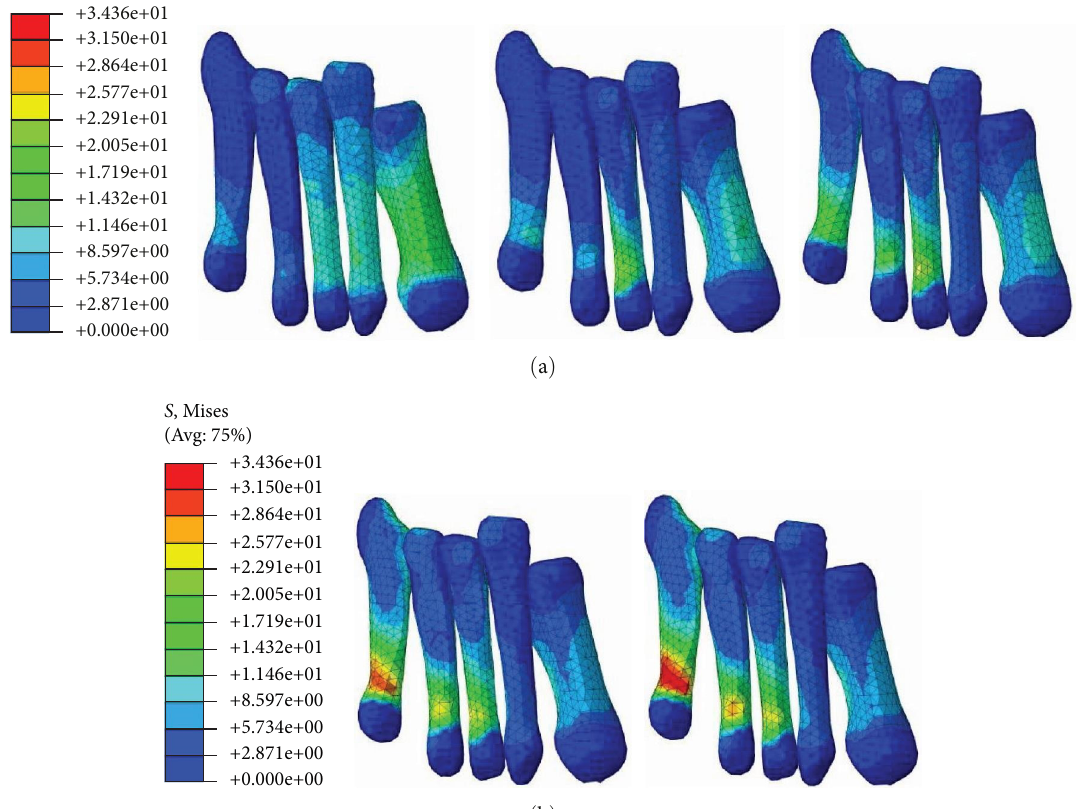
F IGURE 7: Stress distribution of fi ve metatarsals (a) at t 1 , t 2 , and t 3 gait instants in RFS jogging (from left to right) and (b) at t 2 and t 3 gait instants in FFS jogging (from left to